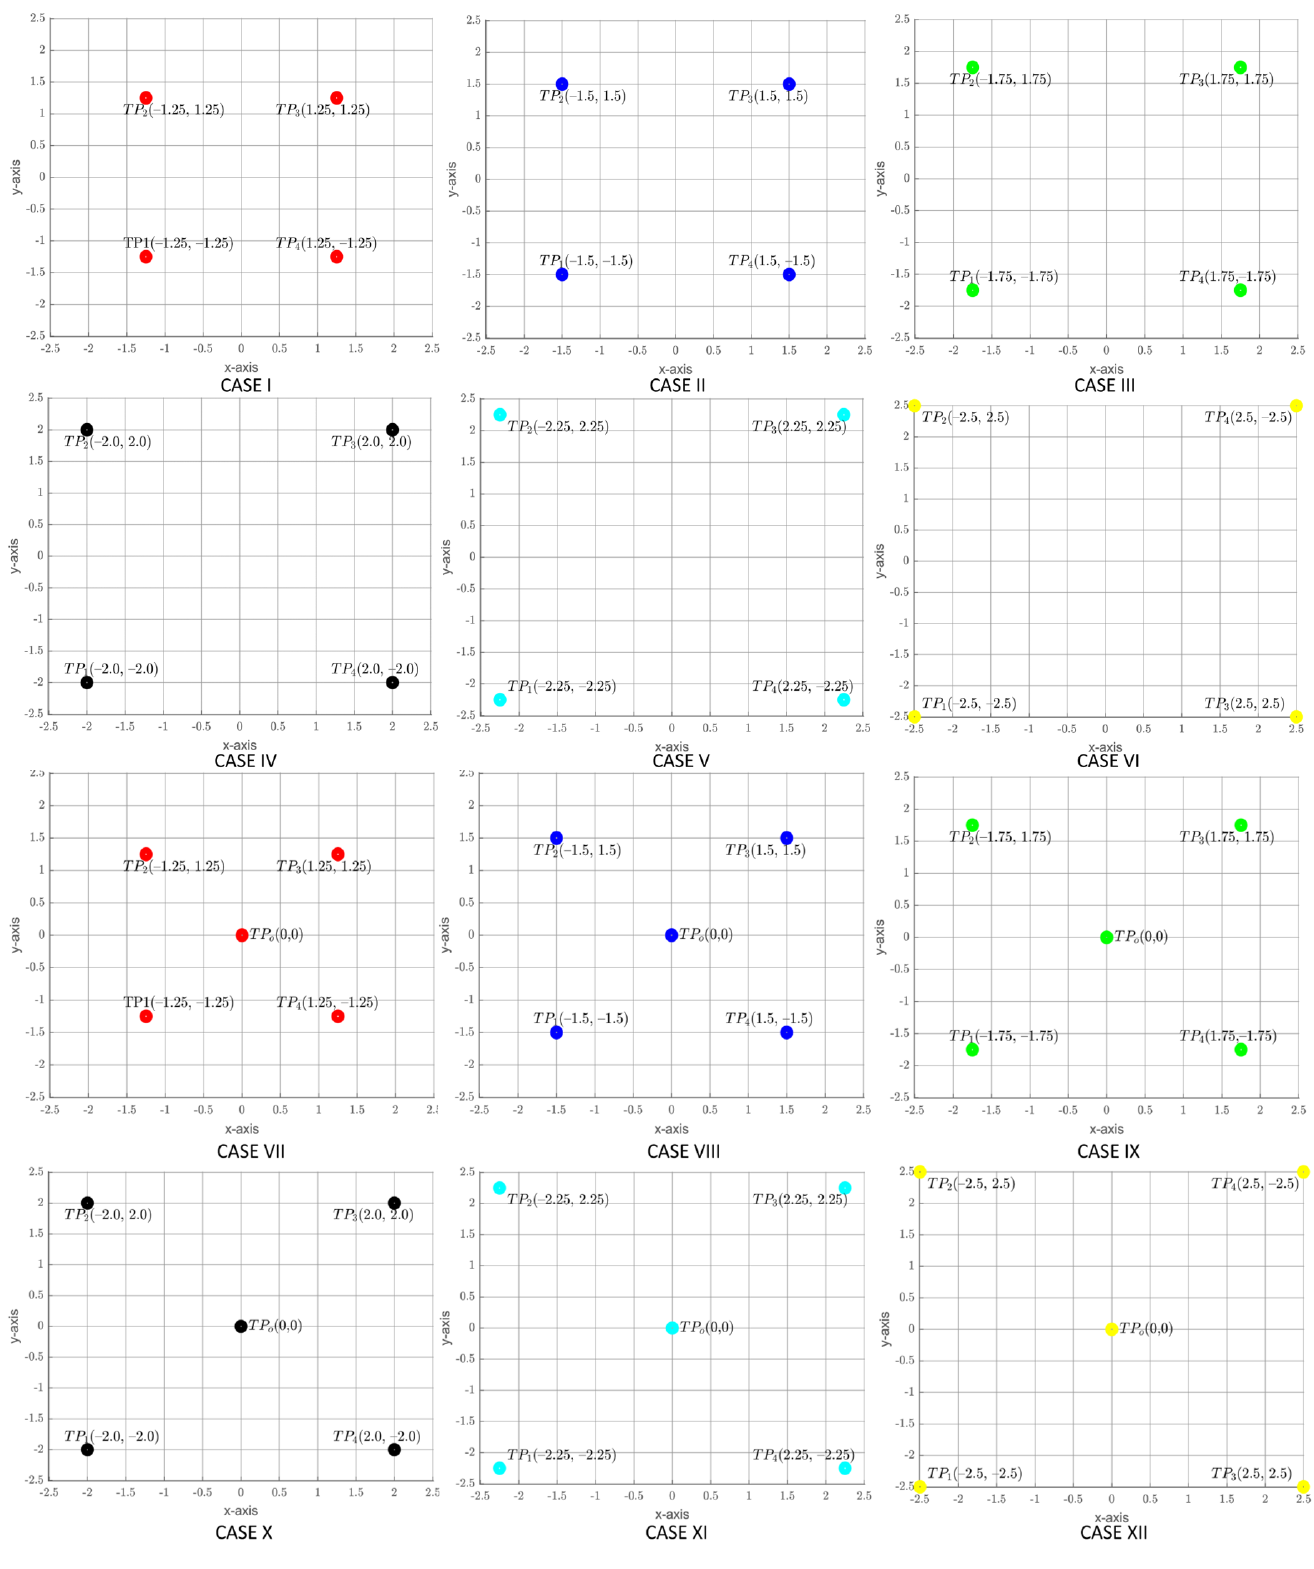
Figure 3. LED lamps placement scenarios: Cases I to